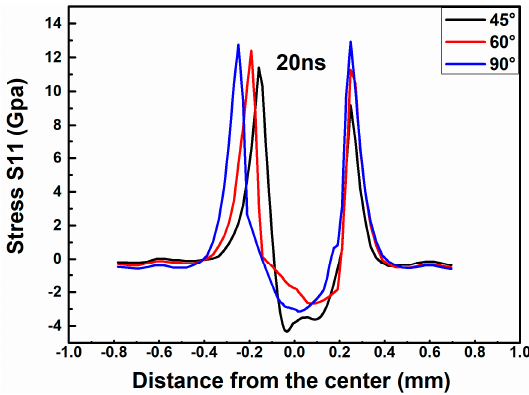
Figure 9. Stress fields of the TiN/Ti coating under different impact angles at 20 ns.